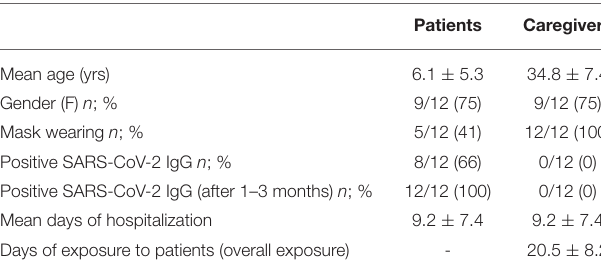
TABLE 1 | Serological and epidemic features of patients and